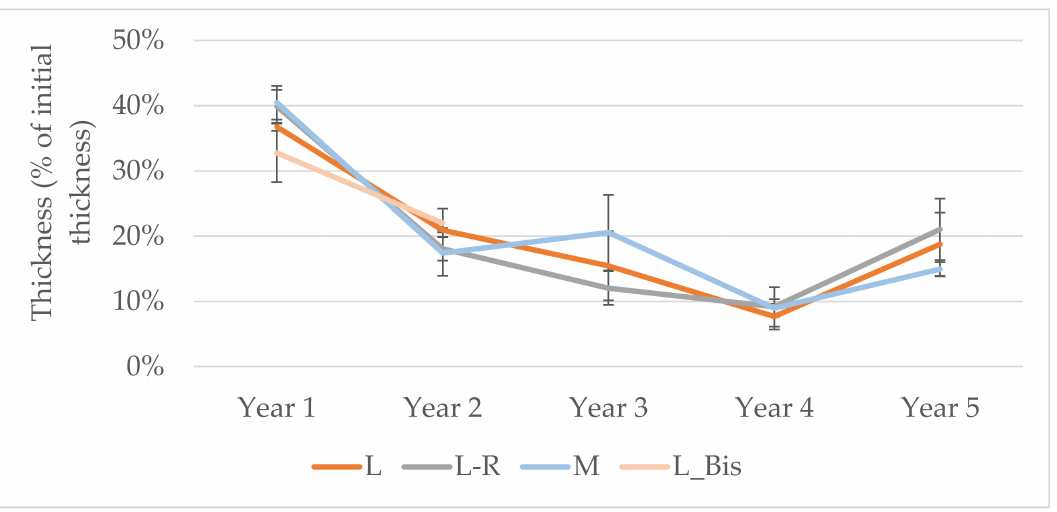
Figure 4. Technosol thickness evolution during the five